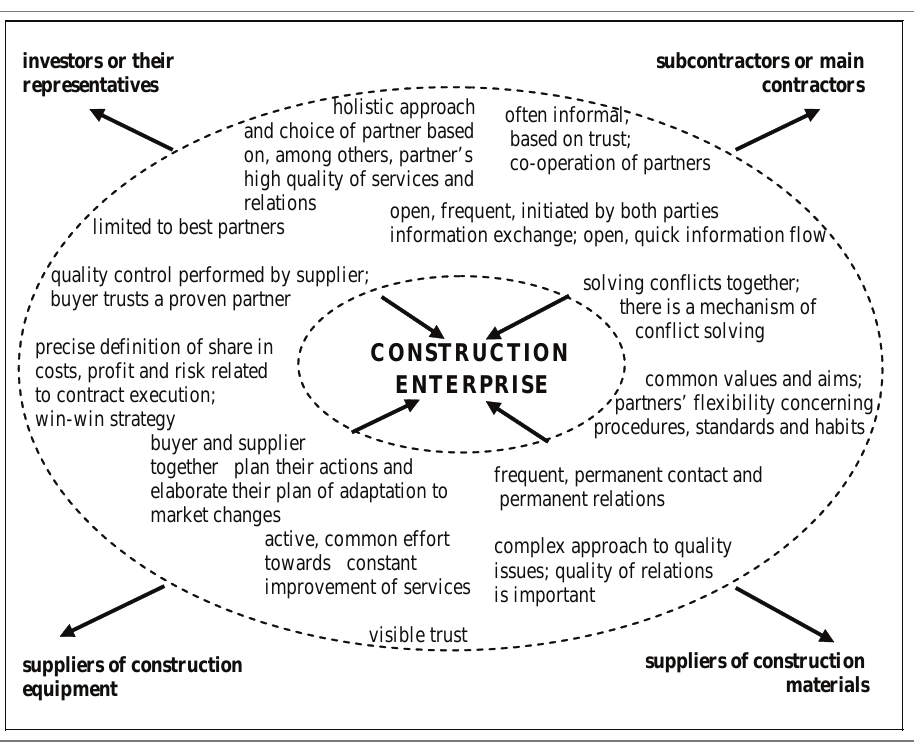
Fig. 1. The graphic model of the partnering relations of construction enterprises with the main transactors in the